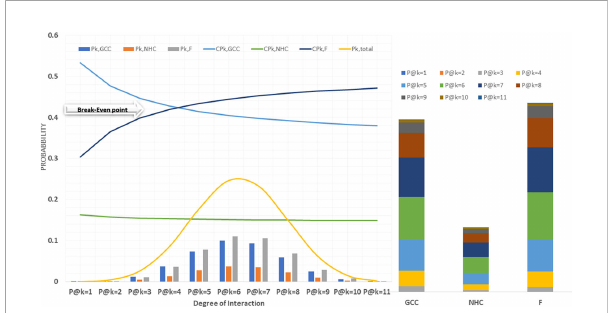
FIGURE 2 Probability distribution @k interactions; P:Probability, CP: conditional